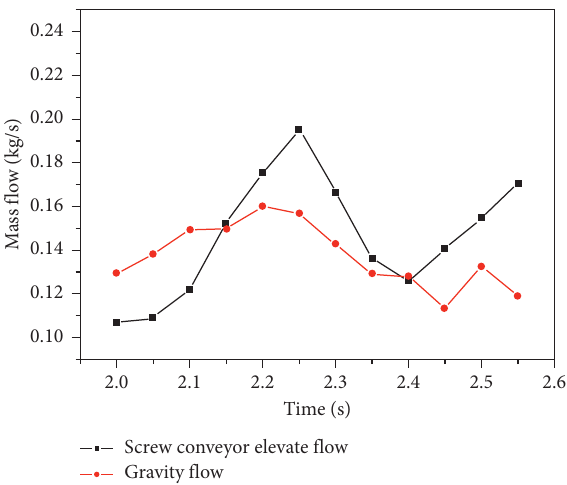
Figure 7: Mass flow rate between dense gravity flow and screw convey flow simulated with